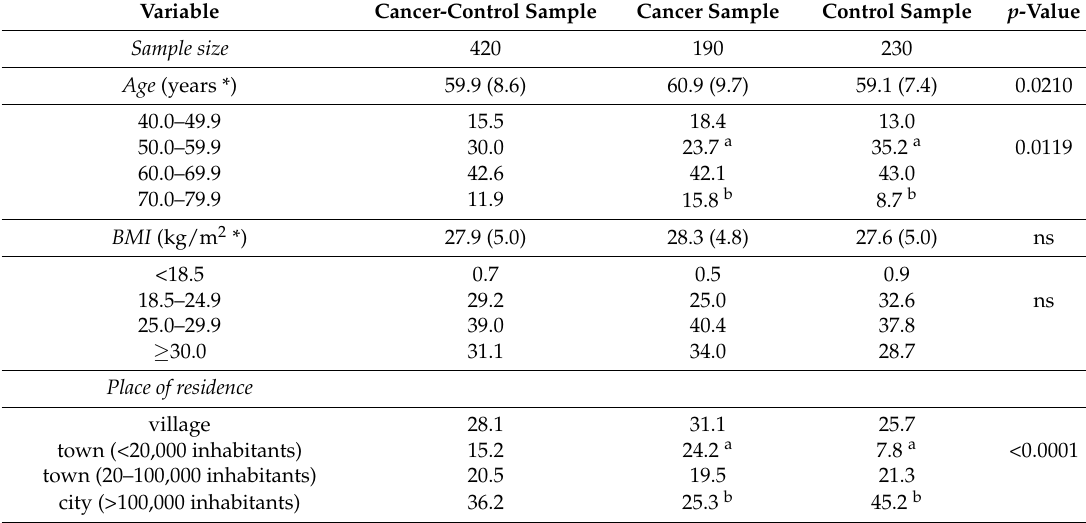
Table 2. Cancer and control sample characteristics